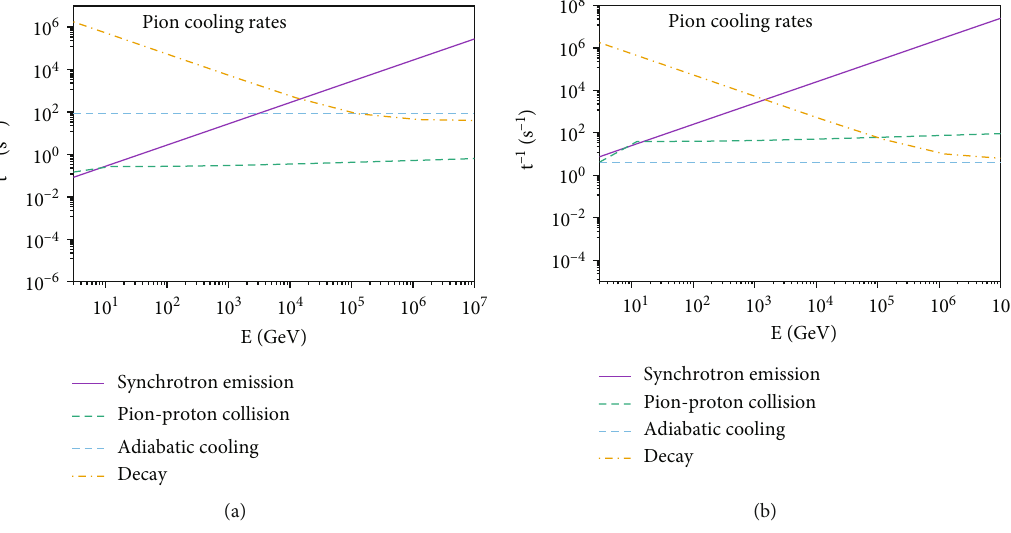
Figure 2: Cooling rates for pions in the jets of M33 X-7 (a) and SS 433 (b) at the base of the